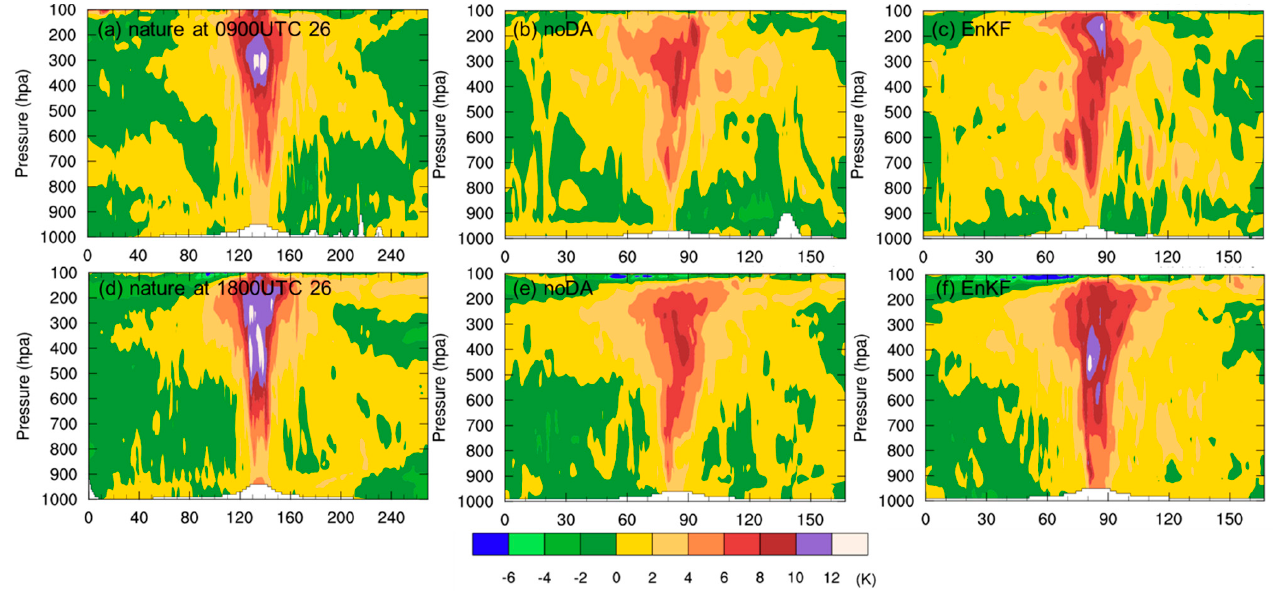
Figure 6. The vertical cross-section of potential temperature anomaly (see text for the description) in nature run (the left column), noDA (the middle column), and EnKF (the right column) at 09:00 UTC ( a – c ) and 18:00 UTC ( d – f ) on 26 October 2020.